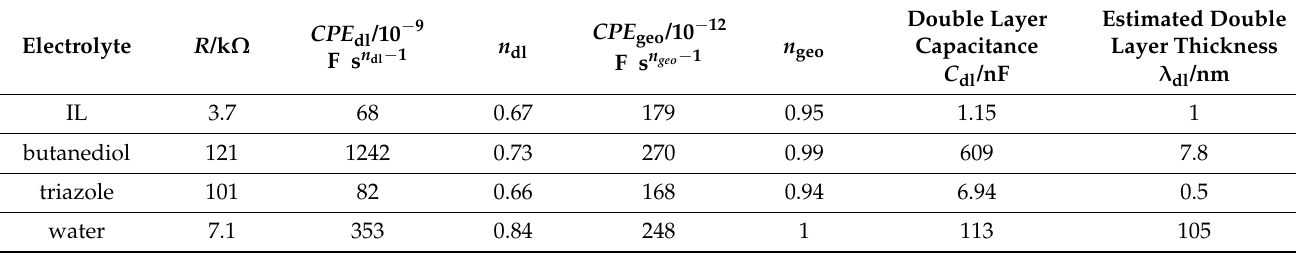
Electrolyte R /k